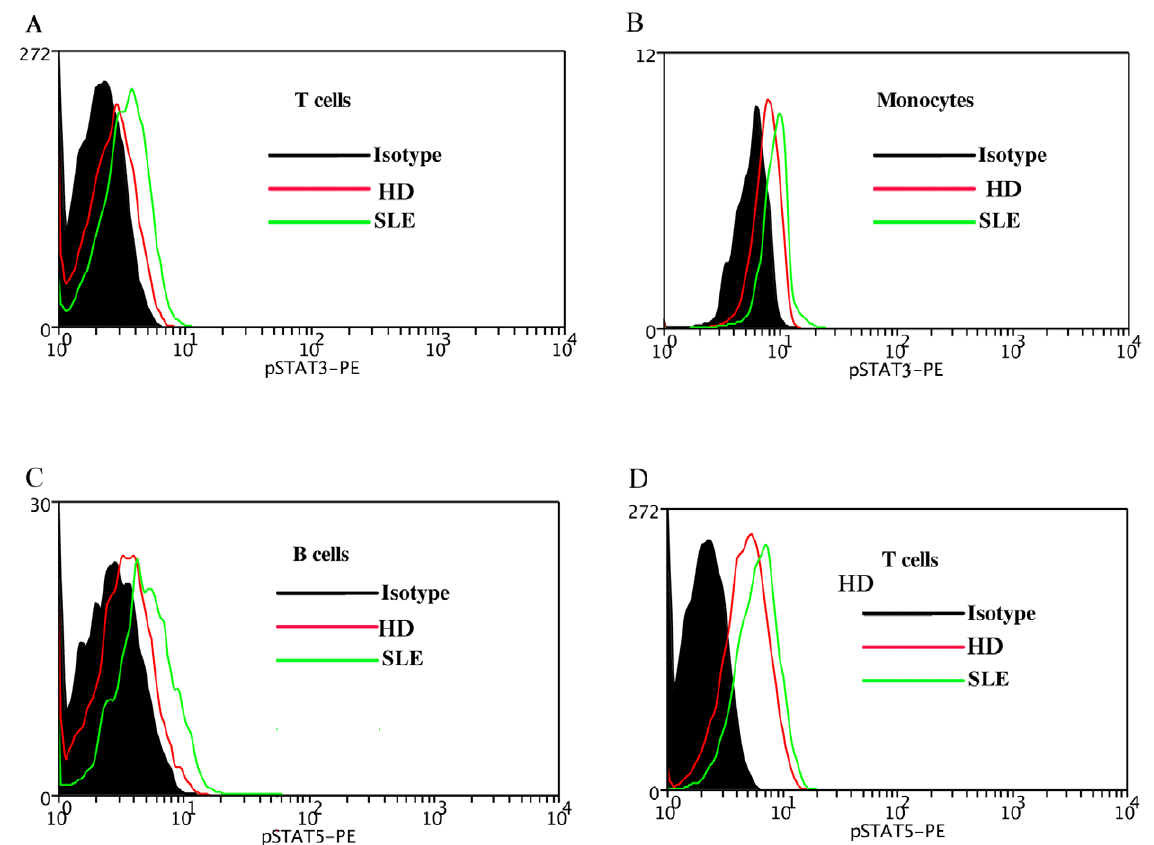
Figure 1. pSTATs expression in SLE patient and healthy donor (HD). A representative experiment is shown. The MFI of pSTAT3 in the T cells (1A), monocytes (1B) of SLE patient was compared with that of HD. The MFI of pSTAT5 in the B cells (1C), T cells (1D) of SLE patient was compared with that of HD. MFI, mean fluorescence index; SLE, systemic lupus erythematosus; HD, healthy donor. doi:10.1371/journal.pone.0021671.g001 Figure 2A). SLE monocytes had significantly higher activation of STAT3 than disease control RA and healthy donors. The expression level of phosphorylation of STAT3 in Monocytes of RA 6.946 6 0.4587, HD 8.648 6 0.3694, SLE vs HD P , 0.05, SLE vs